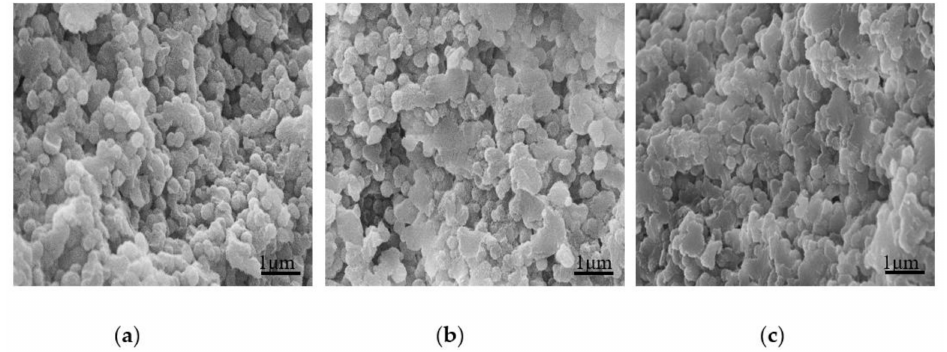
Figure 10. SEM comparison of UF resin with a molar ratio of 1.0 cured under different AlCl 3 additions. ( a ) 1%, ( b ) 3%, ( c )